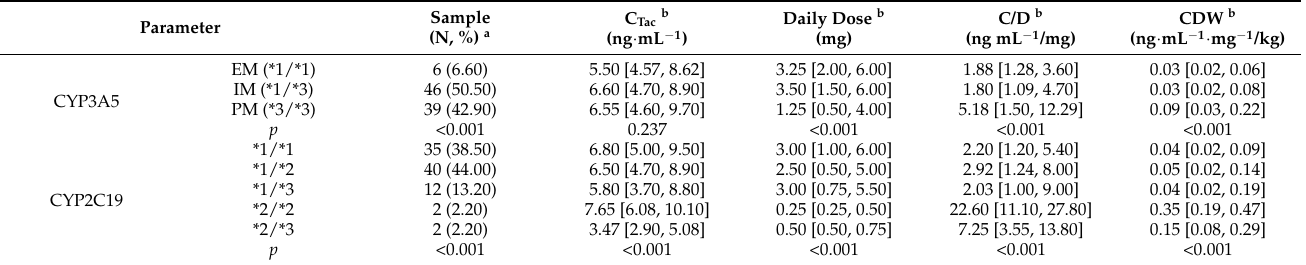
Table 5. Effects of CYP3A5 and CYP2C19 on daily dose, C Tac , C/D, and CDW of tacrolimus.